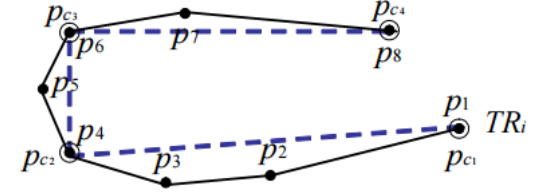
Figure 7. A trajectory and its